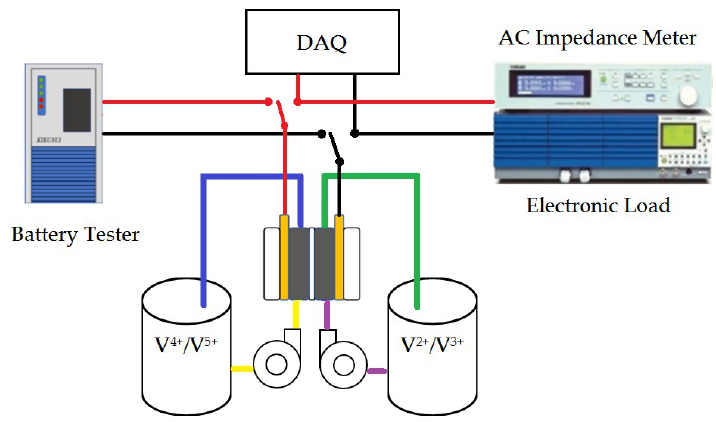
Figure 1. Schematic of experimental setup.